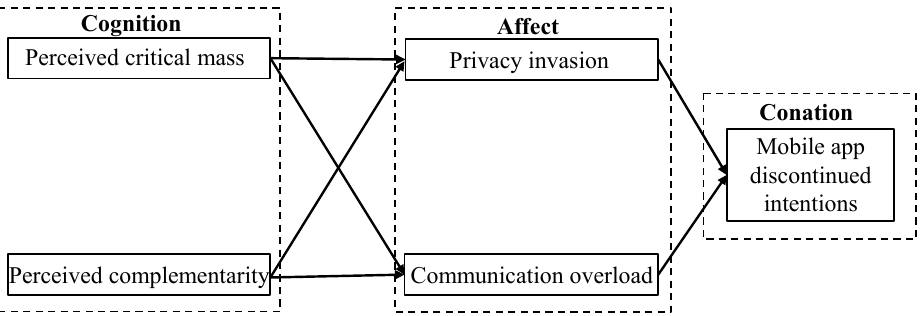
Figure 1. The proposed conceptual research model.